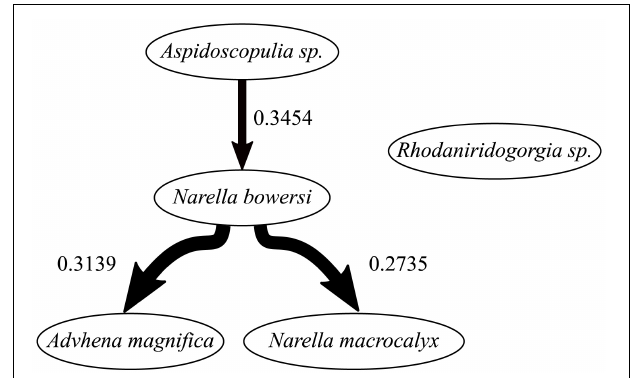
FIGURE 6 | Bayesian networks of associations between abundant sponge and corals. Dependencies between taxa are indicated by the lines connecting the two taxa, the width of which indicates the occurrence rate in the bootstrap analyses (wider lines indicate higher occurrence). Arrows indicate non-mutual dependence between two taxa; A- > B indicates that B depends on A. Mean interaction strengths of the correlations are indicated; positive interaction strengths indicating aggregation, negative interaction strengths indicating segregation. For more details, see section “Materials and